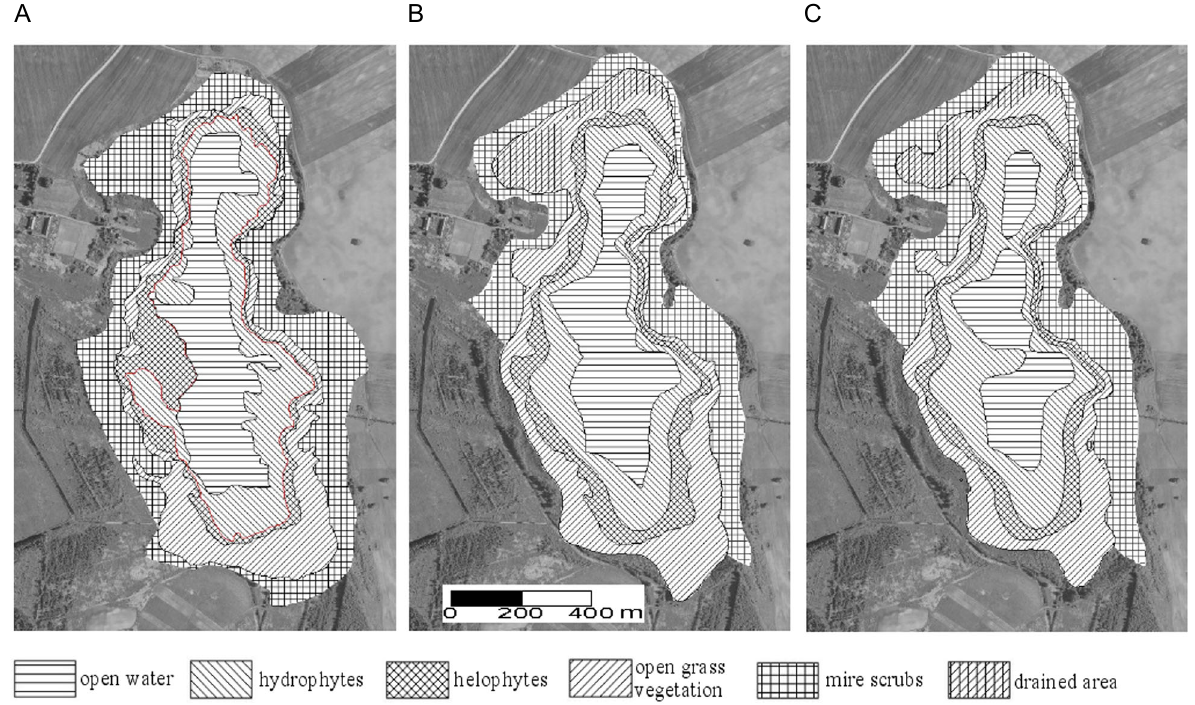
Fig. 6. Sub-wetlands in the Č edasas aquatic ecosystem: A , areas according to orthophotograph and satellite image; B , areas according to isolines in the bathymetrical plan (natural conditions); C , simulated areas (according to isolines) after the 10 cm decline of the water